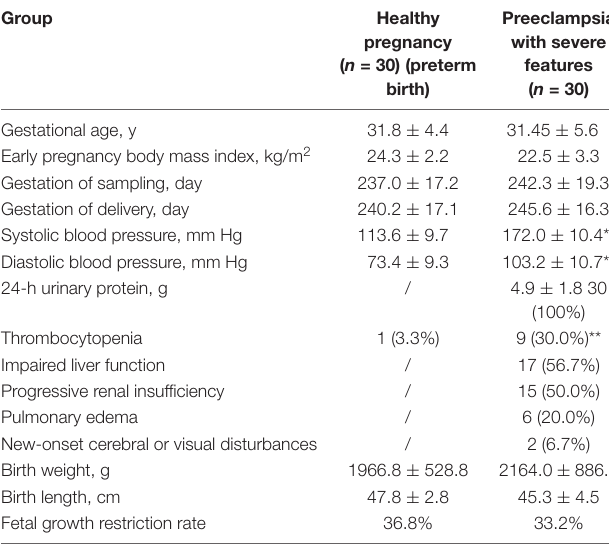
TABLE 1 | Characteristics of the study